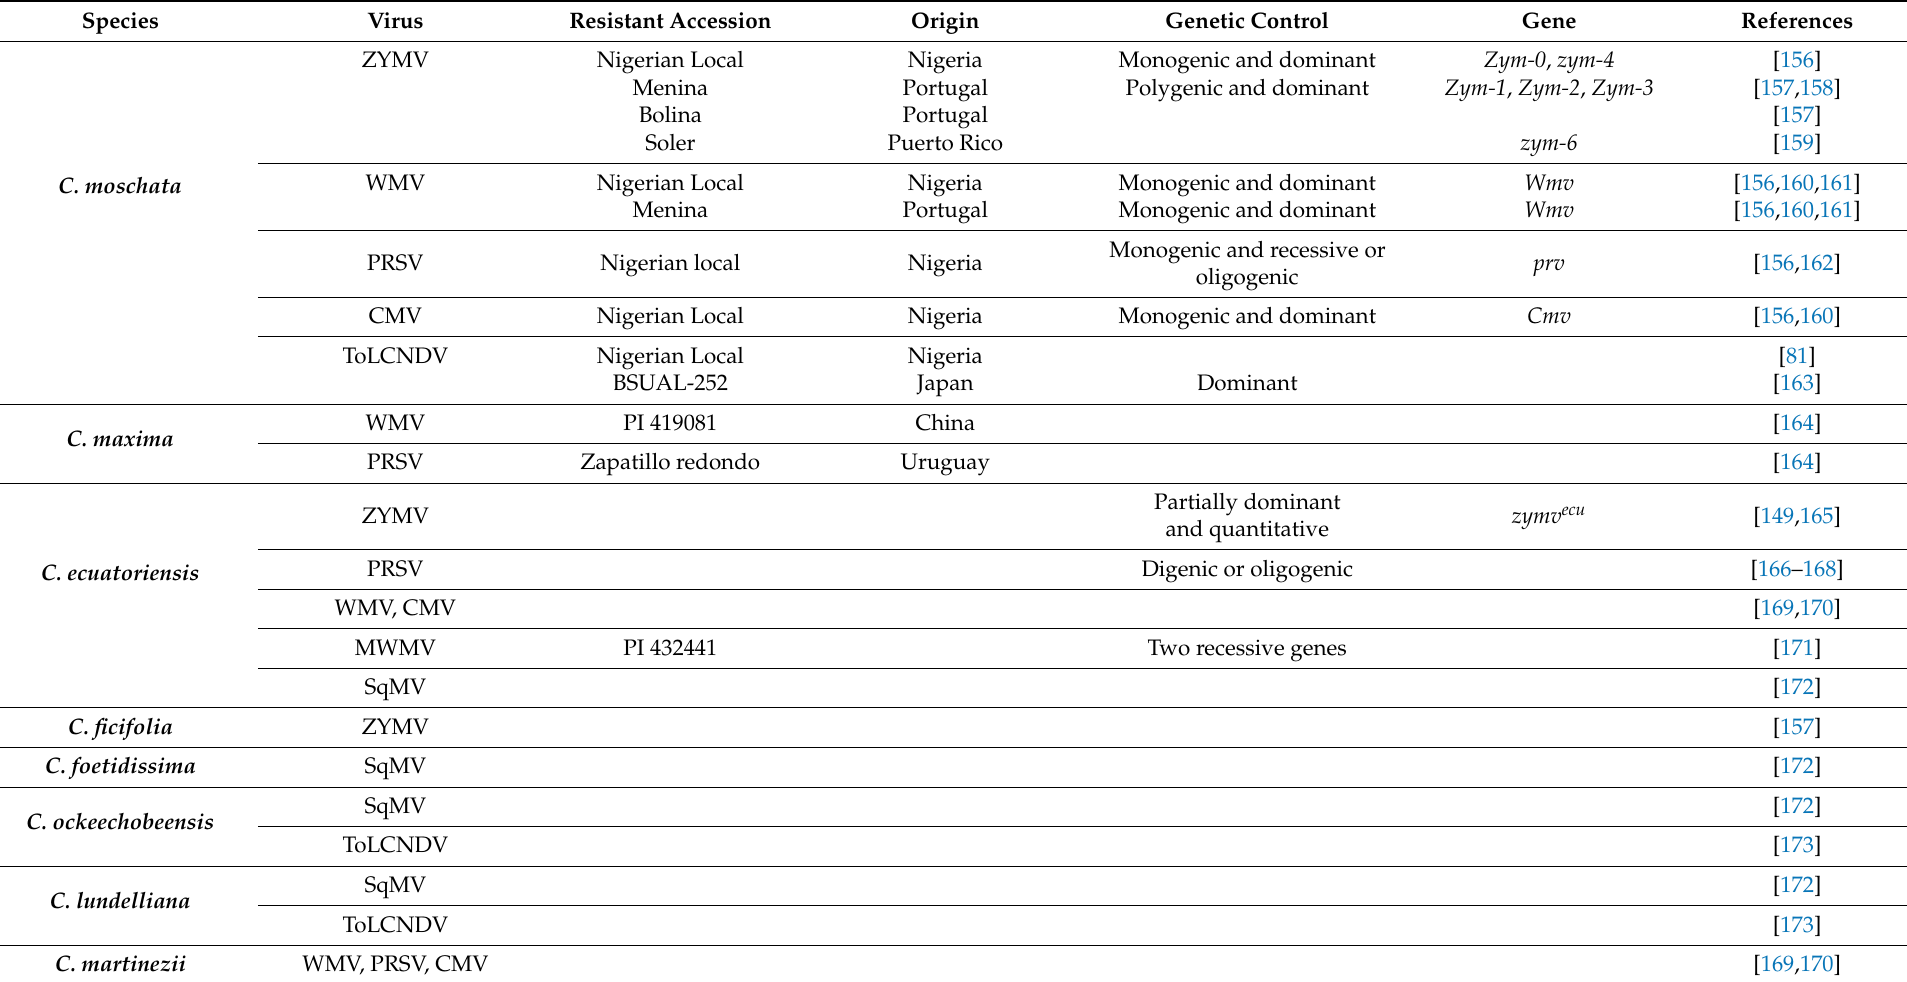
Table 5. Genetic resources for resistance to viruses in Cucurbita